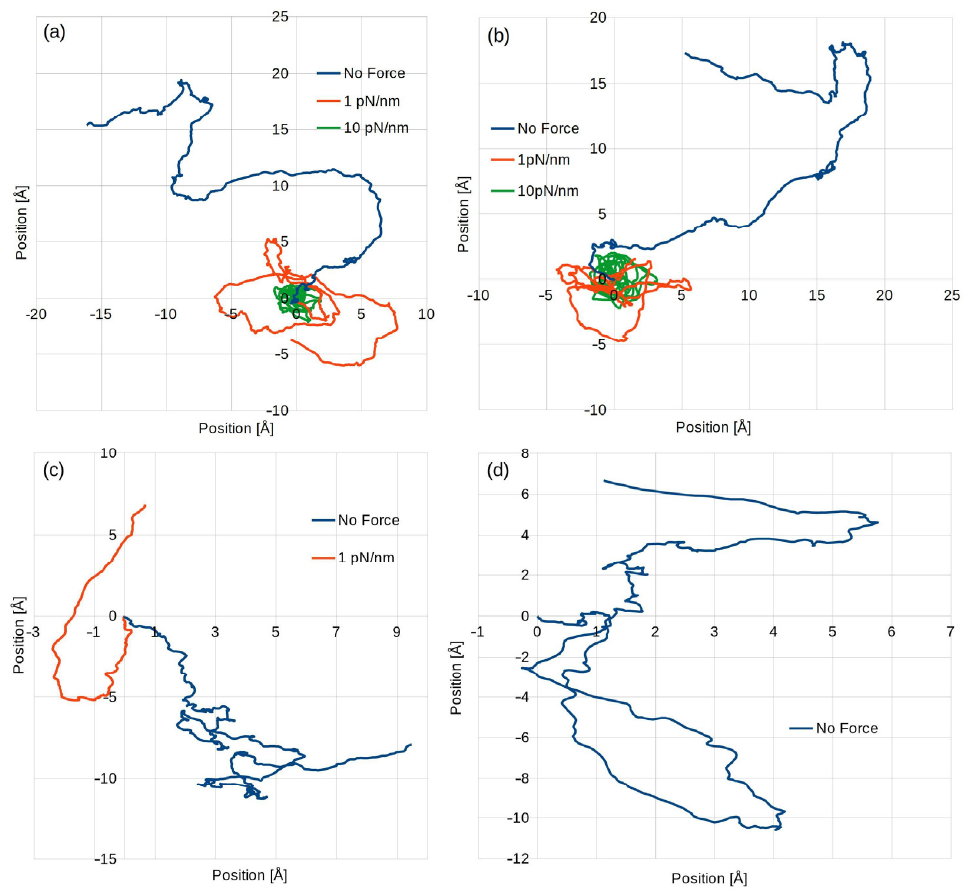
Figure 2. Sample traces of particles for models: SPC ( a ); SPCE ( b ); TIP3P, in this case, there was no